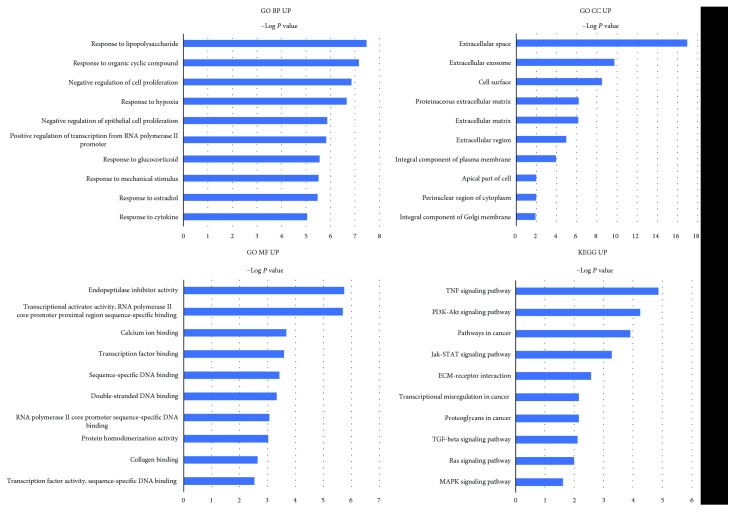
Go function and KEGG pathway enrichment analysis of upregulated genes. Top 5 most significantly enriched GO terms and KEGG pathways of upregulated genes. The length of the bars on the x-axis represents the negative logarithm of the P value (-log10 P) of each pathway; higher (-log10 P) values indicate a higher significance, and lower (-log10 P) values indicate a lower significance. The GO terms and KEGG pathway names are shown on the y-axis. GO MF UP, GO CC UP, and GO BP UP refer to GO terms enriched by upregulated genes. KEGG UP refers to the KEGG terms enriched by upregulated genes.